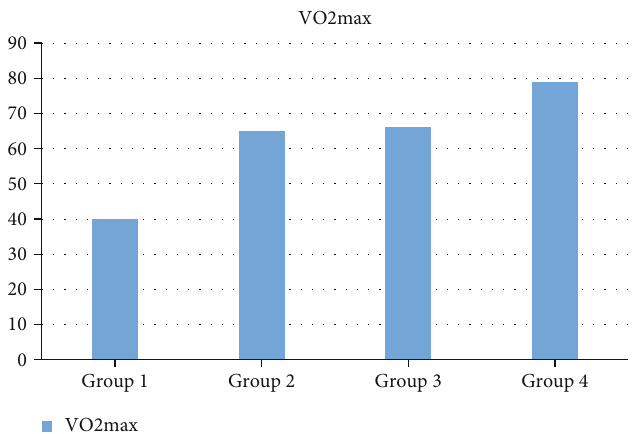
Figure 3: Graph on the results of Queen ’ s test on the di ff erent groups.